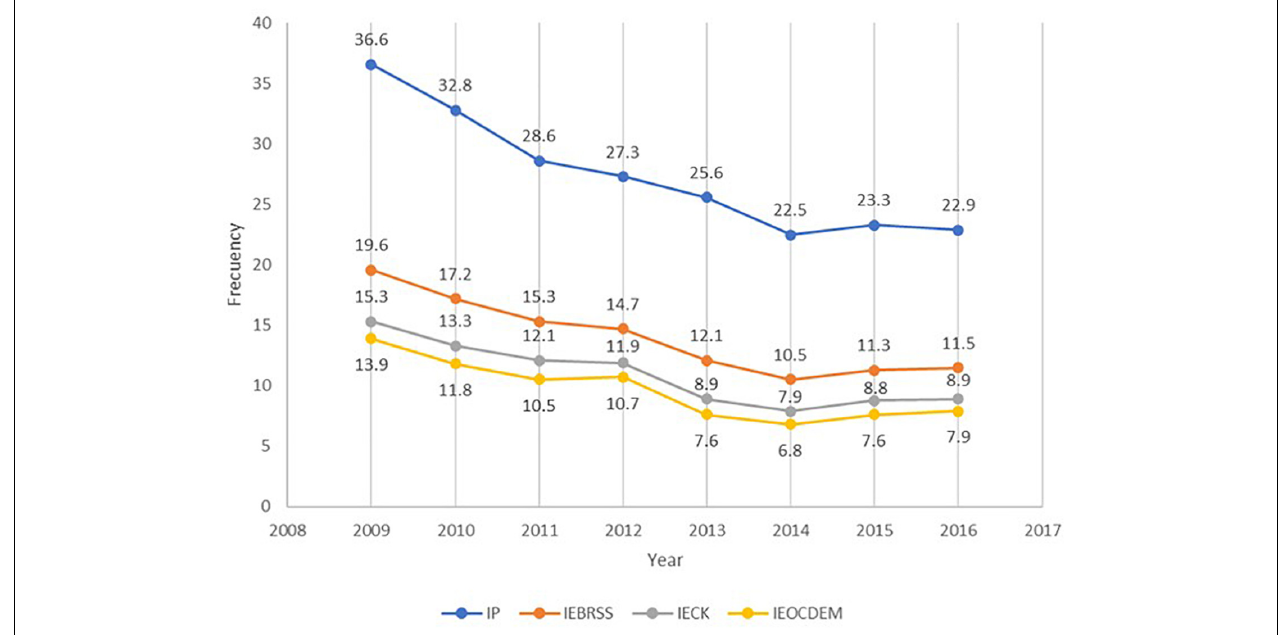
FIGURE 1 | Evolution of the income poverty rate for Ecuador, 2009–2016. Source: Own elaboration with data from the ENEMDU, 2009–2016.